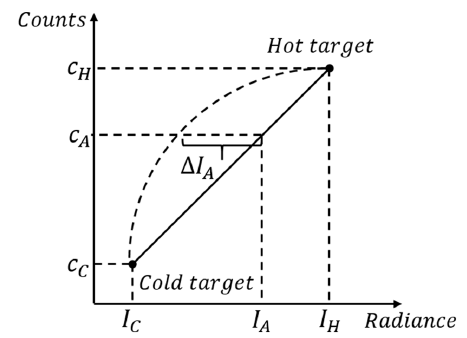
Figure 1. Schematic of two-point calibration.